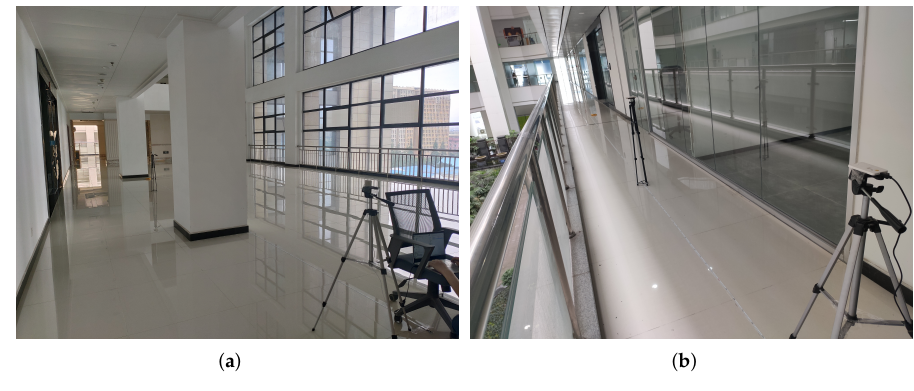
Figure 7. Ranging experiments. ( a ) Hall. ( b ) Corridor.